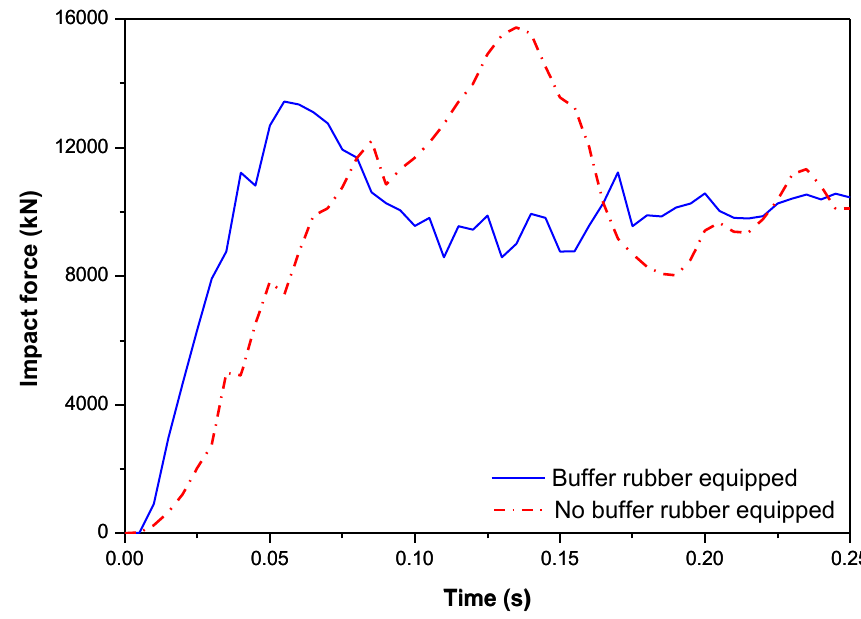
Figure 5. Initial stage of reaction force histories of the bridge pier with and without buffer rubber.